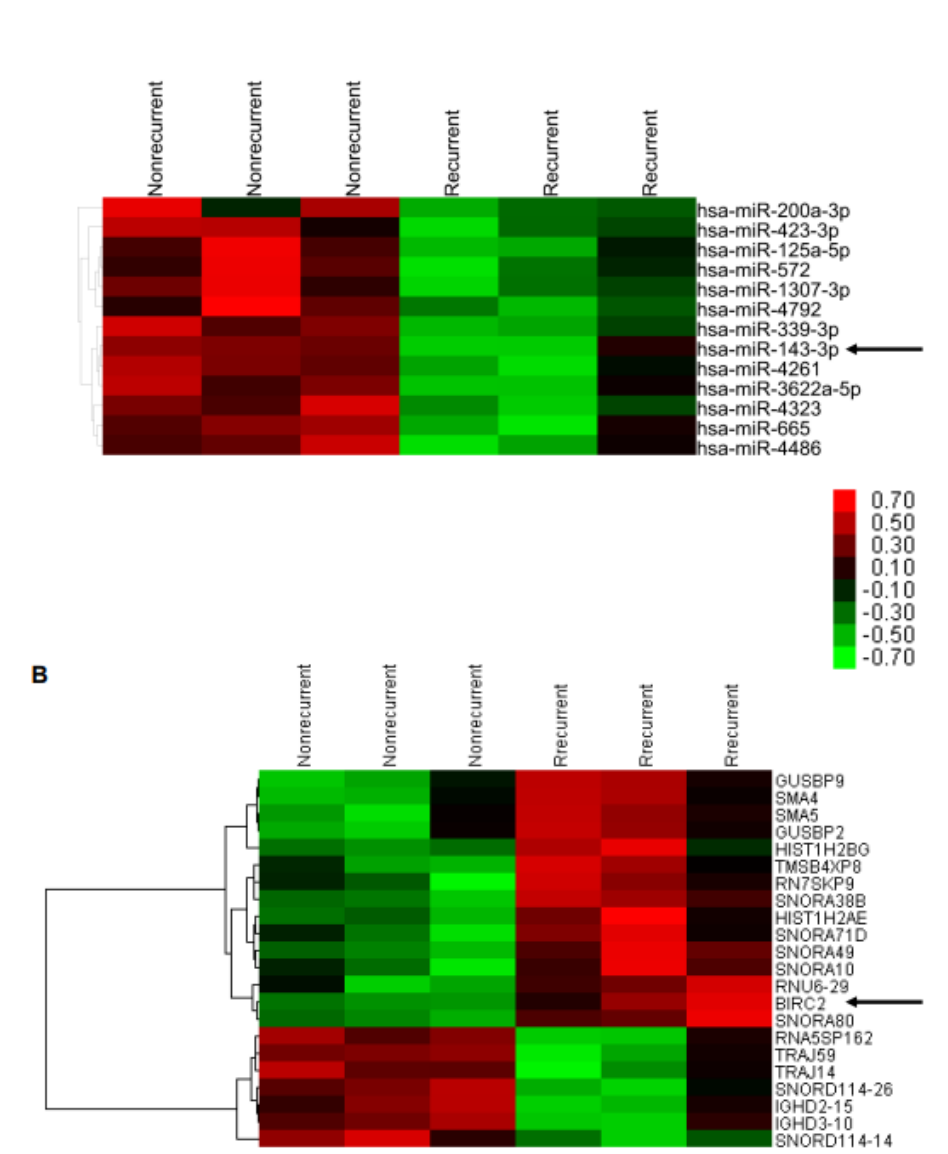
Figure 1. Identification of miRNA − mRNA regulatory relationships. ( A ) miR4.0 array and ( B ) HTA2.0 array analyses were performed on FFPE tissues of patients with recurrent and nonrecurrent cervical squamous cell carcinoma (SCC; n = 3 and 5, respectively).